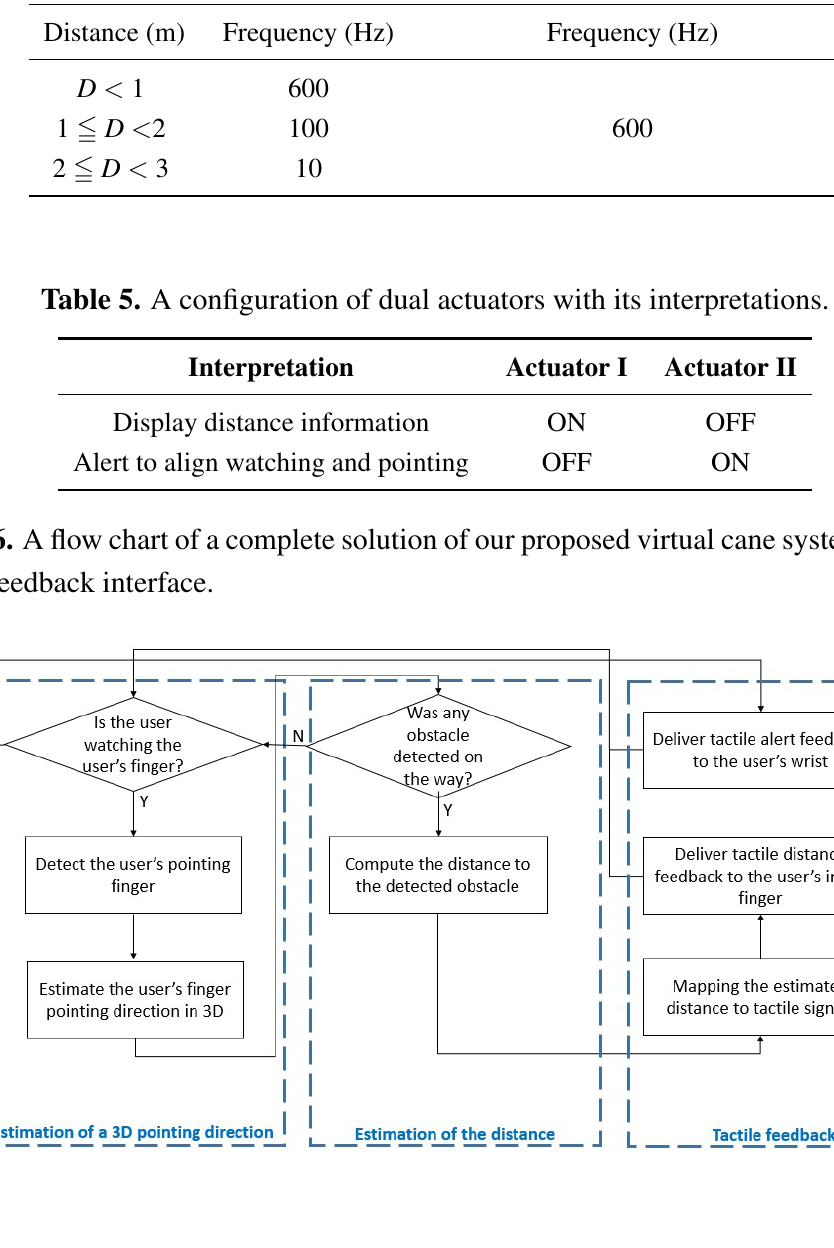
Table 4. A proposed set of identifiable tactile signals with dual actuators used for distinctive distance ranges.